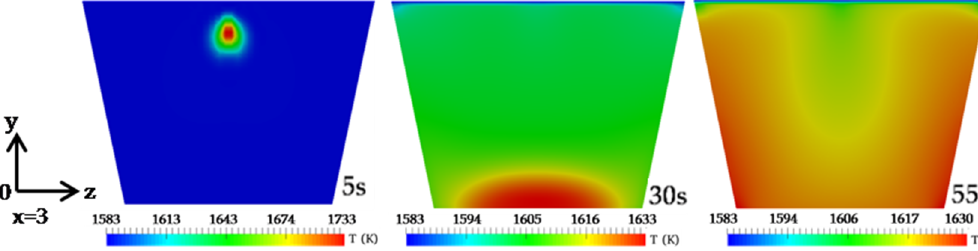
Figure 9. Temperature distribution of the mixture fluid on plane 4 (cf. Figure 3a) at 5, 30 and 55 s.